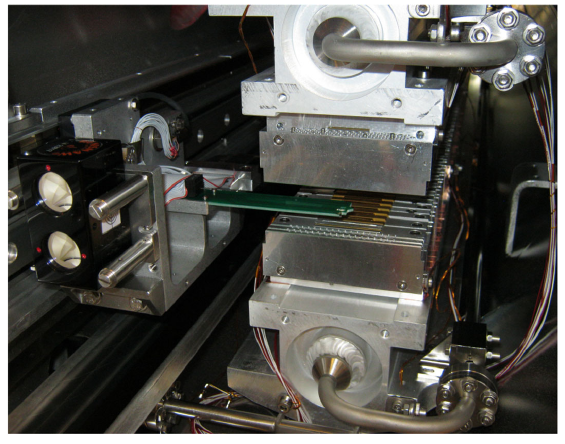
FIG. 8. SOLEIL dedicated magnetic measurement bench inside the vacuum chamber of the cryogenic